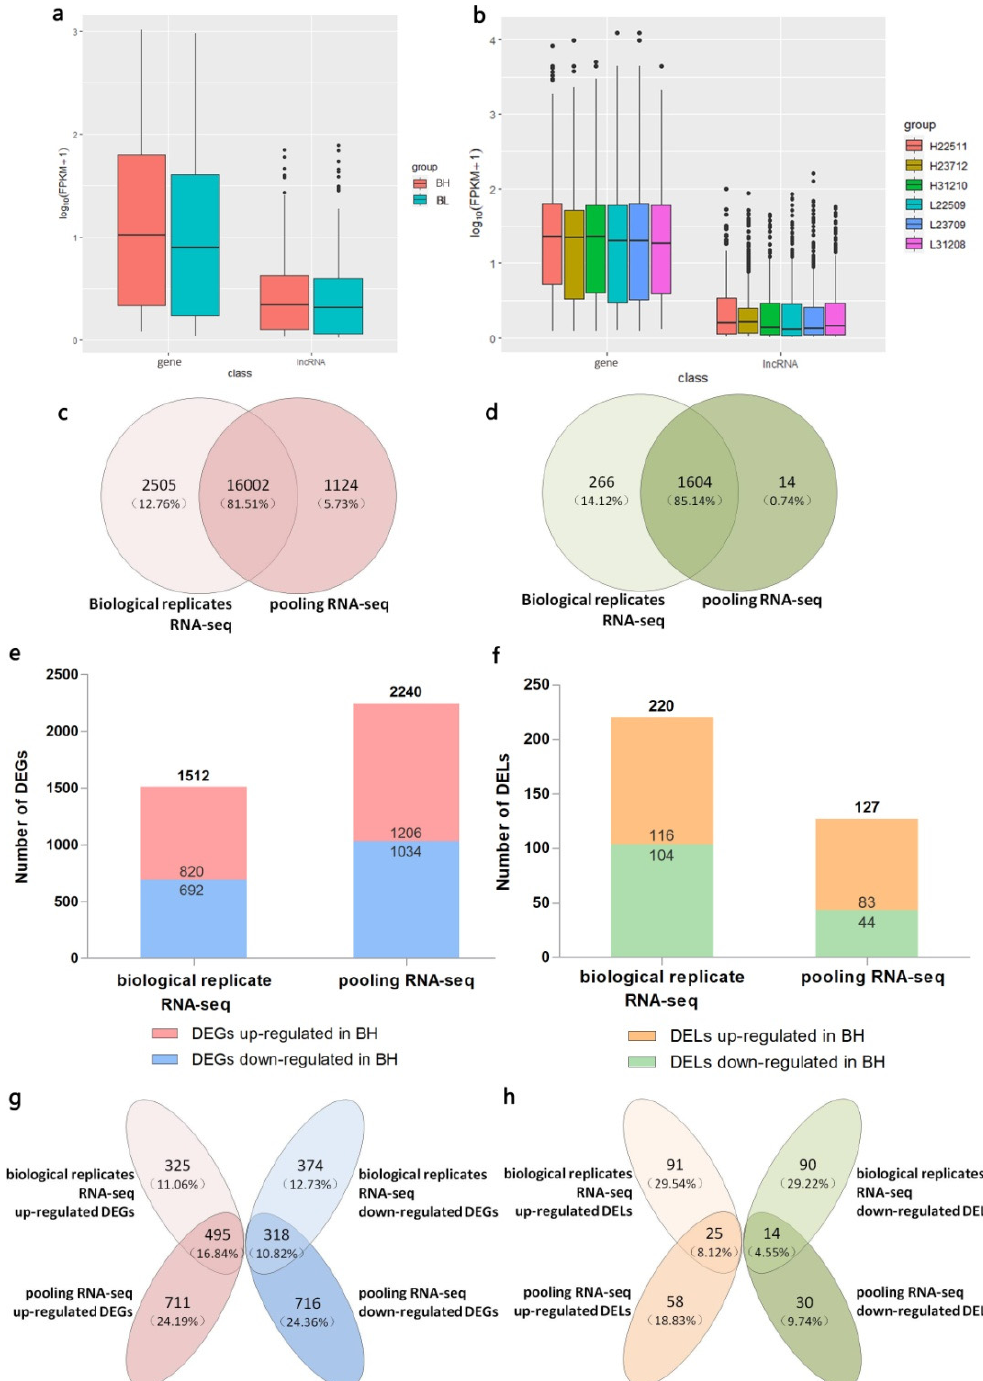
Figure 6. Comparison of pooling and biological replicate RNA sequencing (RNA-seq). ( a ) Comparison of expression levels between the genes and lncRNAs in two groups of pooling RNA-seq. The value of log10 (fragments per kilobase of transcript per million mapped reads [FPKM] +1) is plotted on the Y -axis; ( b ) Comparison of the expression levels between the genes and lncRNAs in six samples of biological replicate RNA-seq; ( c ) Venn diagram of unique genes between two sequencing methods; ( d ) Venn diagram of unique lncRNAs between two sequencing methods; ( e ) Number of differentially expressed genes (DEGs) between BH and BL groups of two sequencing methods; ( f ) Number of differentially expressed lncRNAs (DELs) between BH and BL groups of two sequencing methods; ( g ) Venn diagram of DEGs of two sequencing methods; ( h ) Venn diagram of DELs of two sequencing methods.